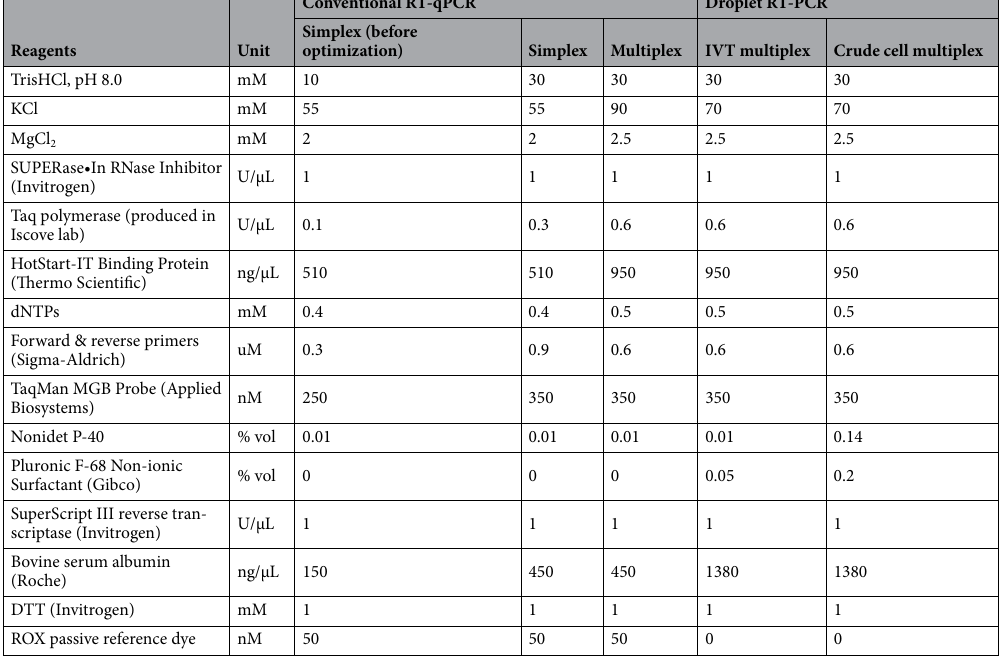
Table 2. Formulation of the simplex and multiplex RT-PCR reagent